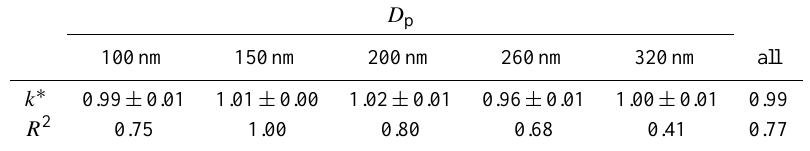
Table 4. Correlation of measured and predicted F in (429 data points for individual size bins; 2145 data points for all size bins).